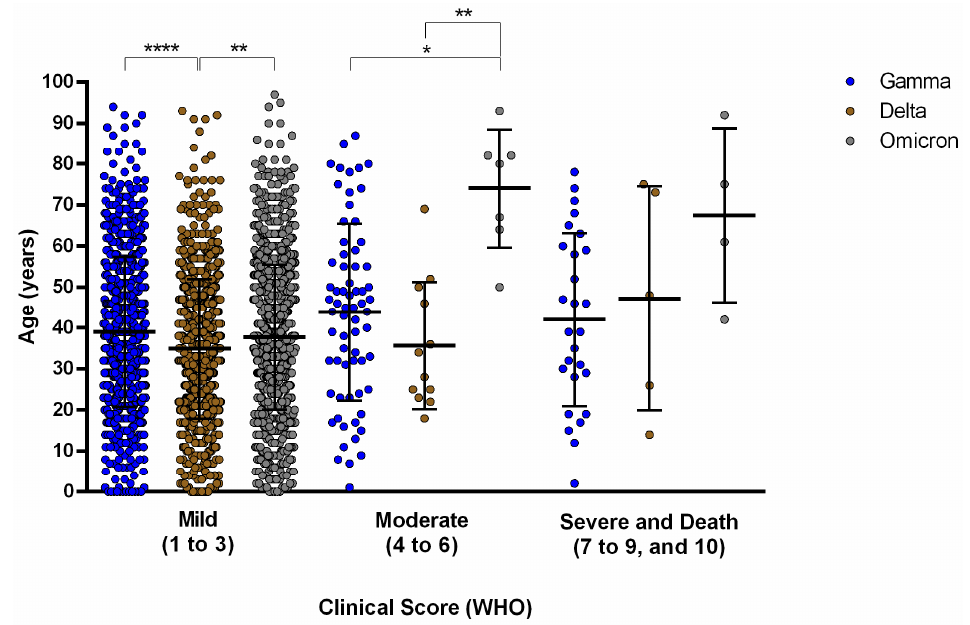
Figure 2. Distribution of positive COVID-19 cases caused by Gamma, Delta, and Omicron variants according to the clinical scores of the World Health Organization compared to patients’ age. Clinal scores of 1 to 3 were classified as mild, 4 to 6 as moderate, 7 to 9 were severe, and 10 for death. Data are expressed in average age (years) ± standard deviation. Statistical analysis was performed using Kruskal–Wallis with Dunn’s test for correction of multiple comparisons and α = 0.05, p > 0.05 (not significant), p < 0.05 (*), p < 0.01 (**), and p < 0.0001